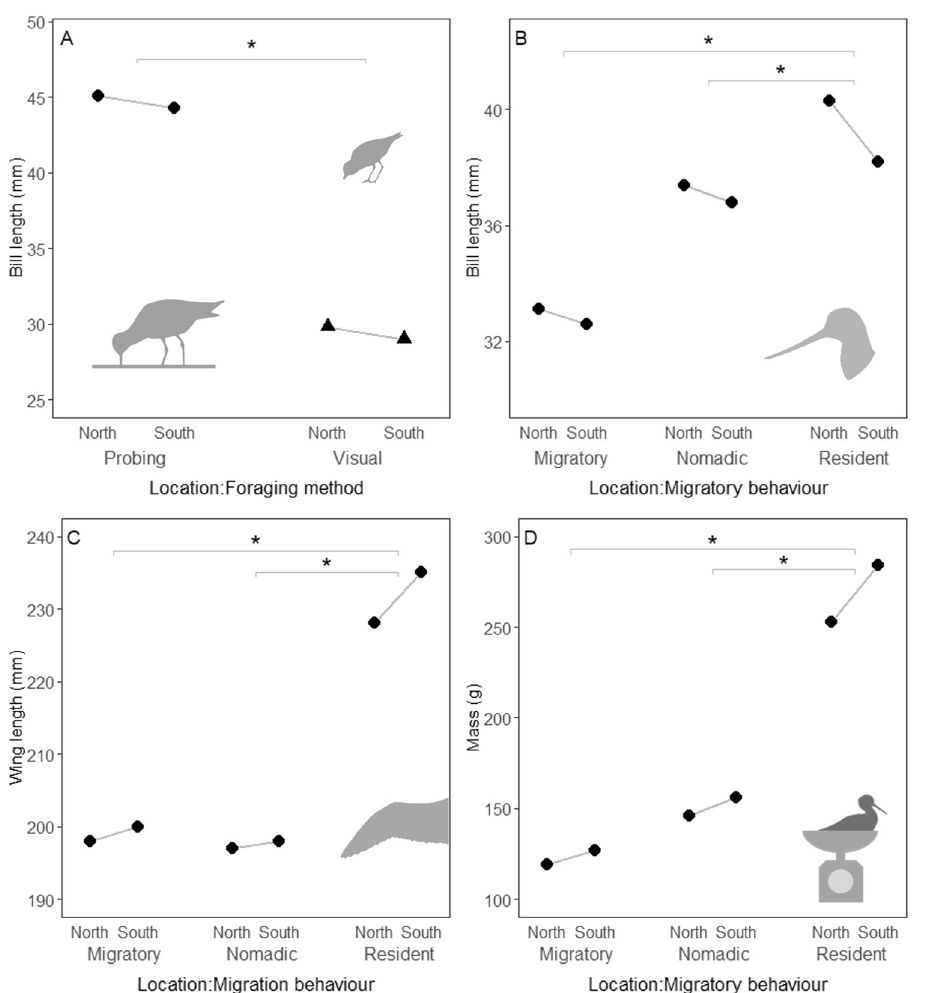
Fig. 3 | Summary of morphological differences between different bird groups. Model predicted means of bill length ( A , B ), wing length ( C ) and mass ( D ) according to population location (North = northern Australia, South = southern Australia) and ( A ) foraging method or ( B – D ) migratory behaviour. Predicted